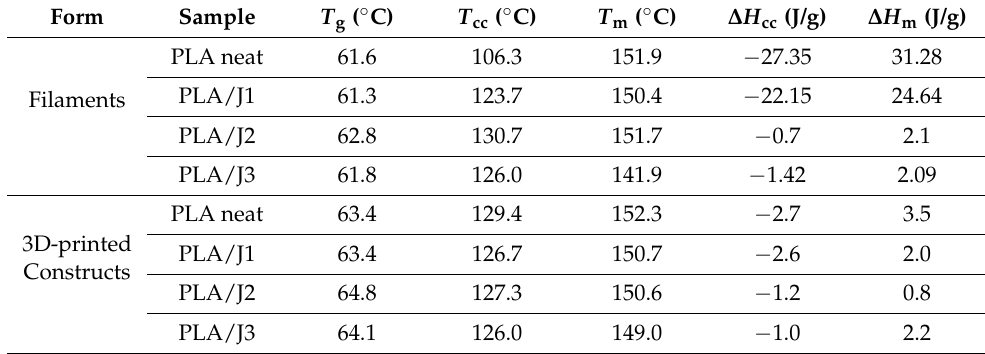
Table 2. DSC results of the PLA filaments and 3D-printed constructs.